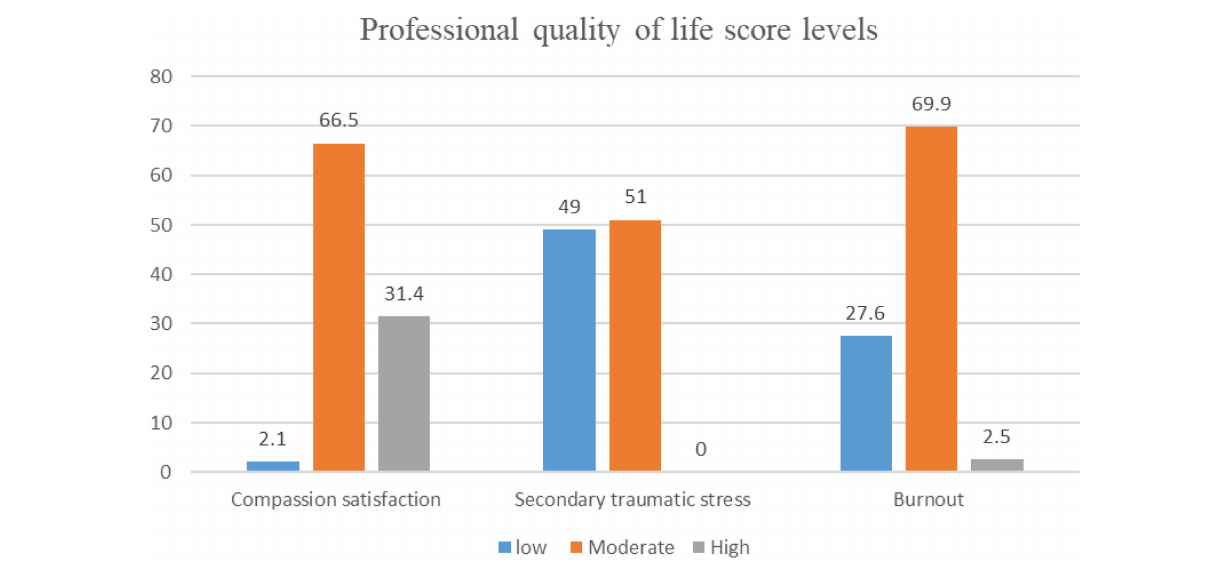
FIGURE 1 | The level of professional quality of life during